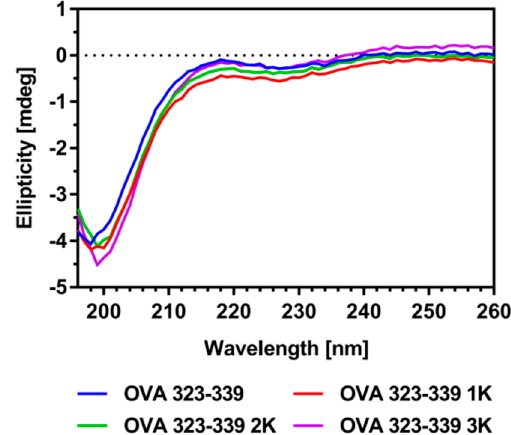
Figure 2. CD spectra of OVA 323-339 and its lysine-flanked variants. Representative blank-subtracted far-UV CD spectra are shown. Measurements were performed in triplicate in 5 mM PB sucrose pH 6.5 at a peptide concentration of 20 µM. CD spectra at other study-relevant conditions can be found in the supplement (Figure S1)